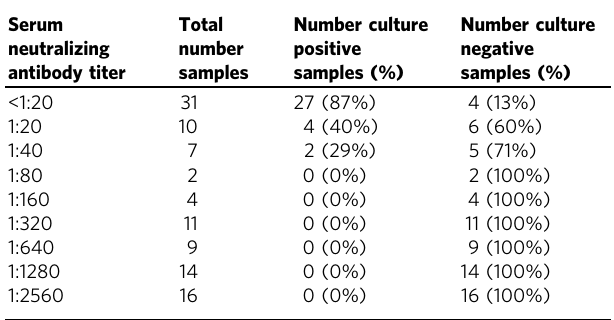
Table 2 Serum neutralizing antibody titers and isolation of infectious virus from the respiratory